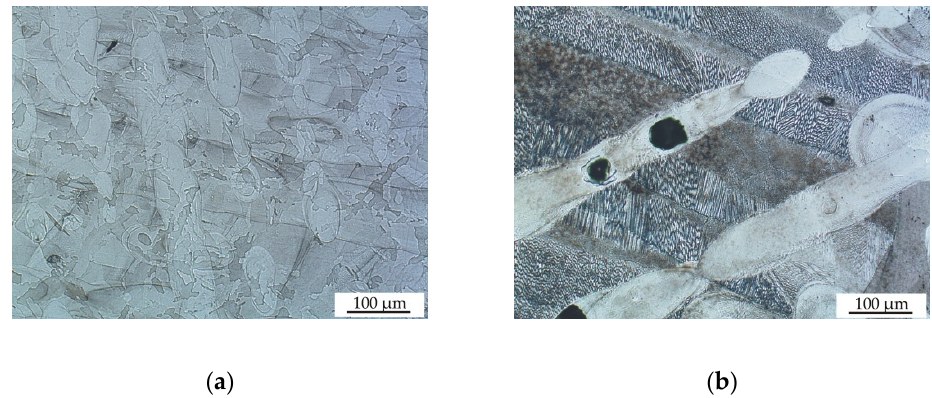
Figure 9. ( a ) OM image of sample 2 after SLM and ( b ) OM image of sample 13 after SLM, etched with Carpenter reagent.